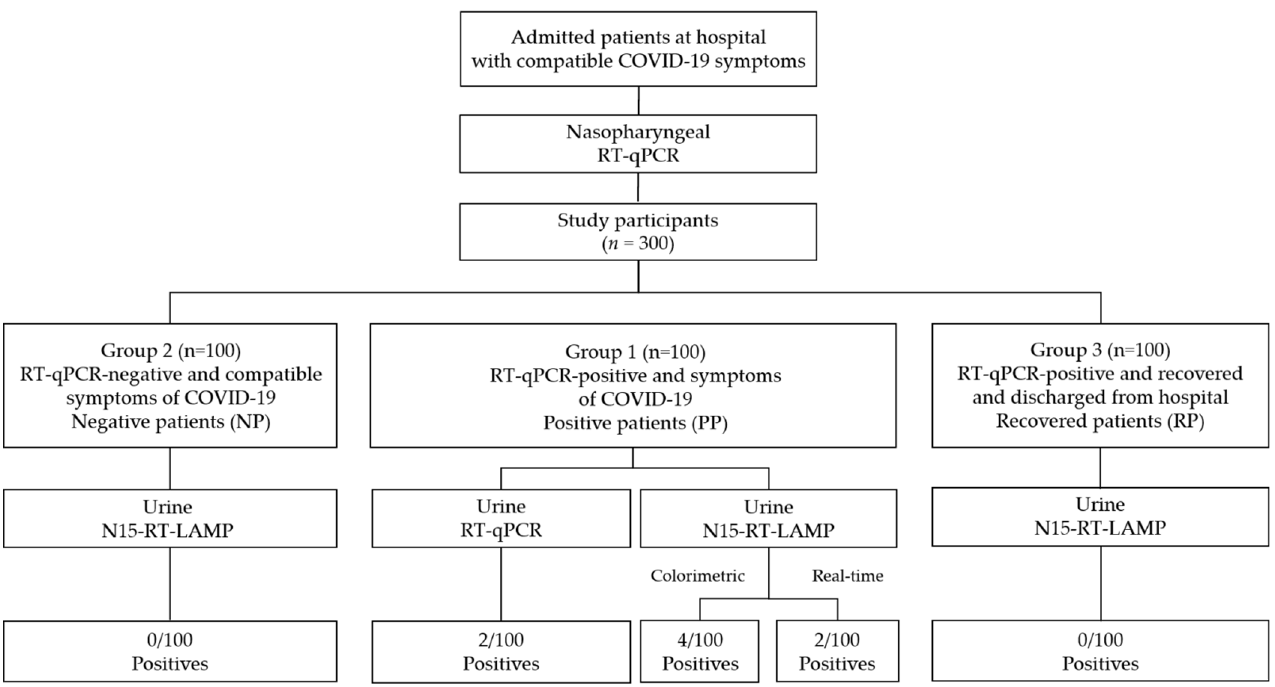
Figure 1. Flowchart describing the process of patient group selection and urine sample analysis strategy. RT-qPCR, reverse transcription-polymerase chain reaction; RT-LAMP, reverse transcription loop-mediated isothermal amplification.